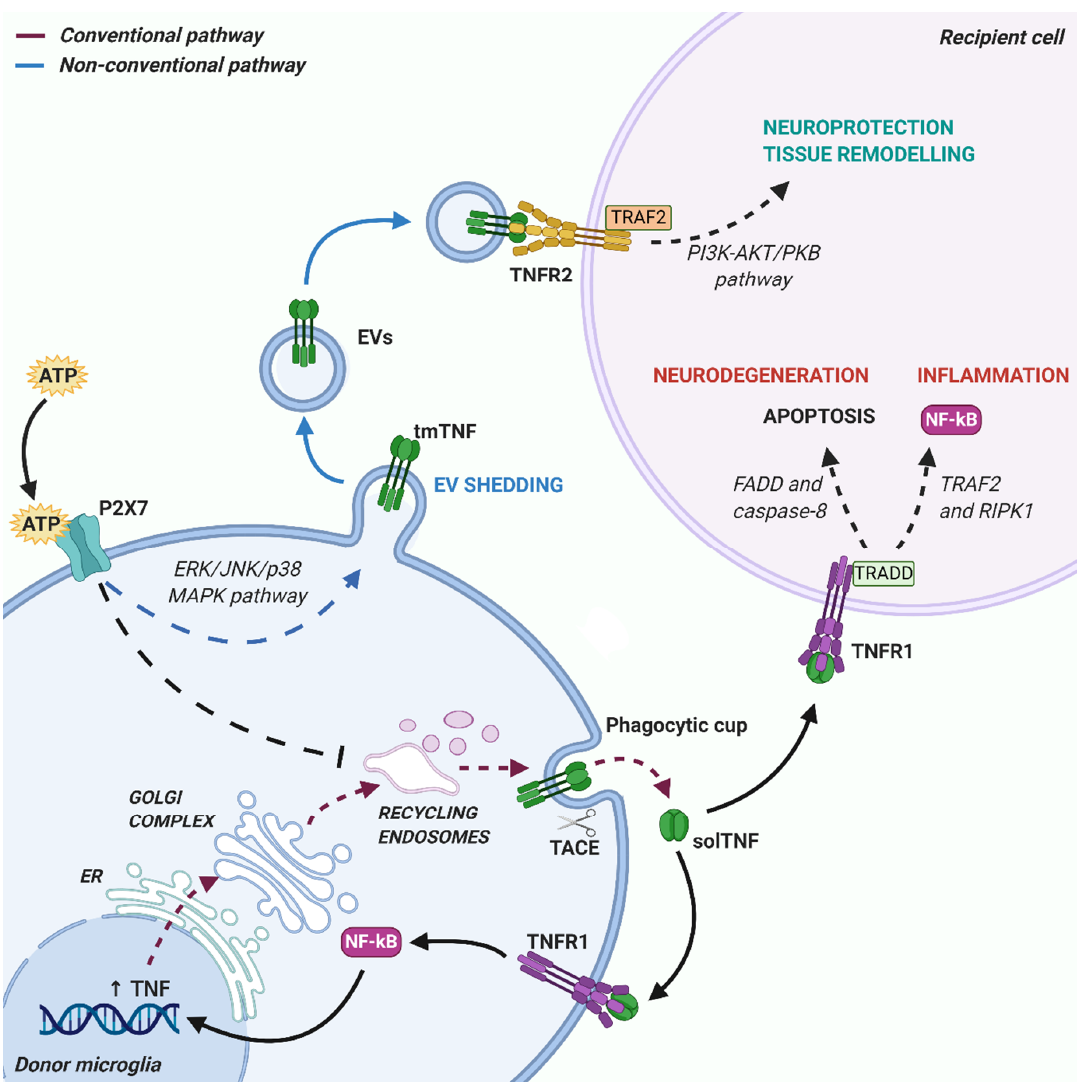
Figure 1. Schematic representation of the conventional and non-conventional pathways of tumor necrosis factor (TNF) release from microglia. The conventional pathway (purple dashed lines) requires cytokine localization in the endoplasmic reticulum (ER), where it is correctly folded and transported to Golgi complex for final post-translational modifications. TNF is then exposed on cell membrane (transmembrane TNF (tmTNF)) in the phagocytic cup, where it is cleaved by TNF converting enzyme (TACE) and released as a soluble form of TNF (solTNF) in the extracellular space. Released solTNF is able to interact with TNFR1 receptor on recipient cells and induce pro-inflammatory and neurodegenerative effects, or to bind TNFR1 receptors on donor microglial cells, creating a positive feedback loop reinforcing TNF production. The non-conventional release pathway (blue lines) instead consists in tmTNF membrane localization via an ER—Golgi independent route, avoiding post-translational modifications. In this case, bearing outside of the phagocytic cup and distant from TACE enzymes, tmTNF is protected from cleavage and can be packed into shedding EVs. Thus, EV-carried tmTNF preferentially interacts with TNFR2 receptors on target cells, triggering protective responses. Interestingly, ATP-mediated activation of P2X7 receptors on donor microglial cells is able to influence these mechanisms, inhibiting the conventional release pathway and favoring non-conventional TNF release into EVs. Created with BioRender.com.